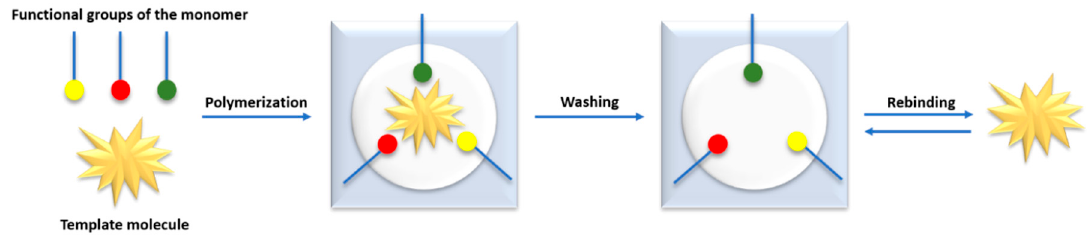
Figure 9. The general process of creation of molecularly imprinted polymers (MIPs).